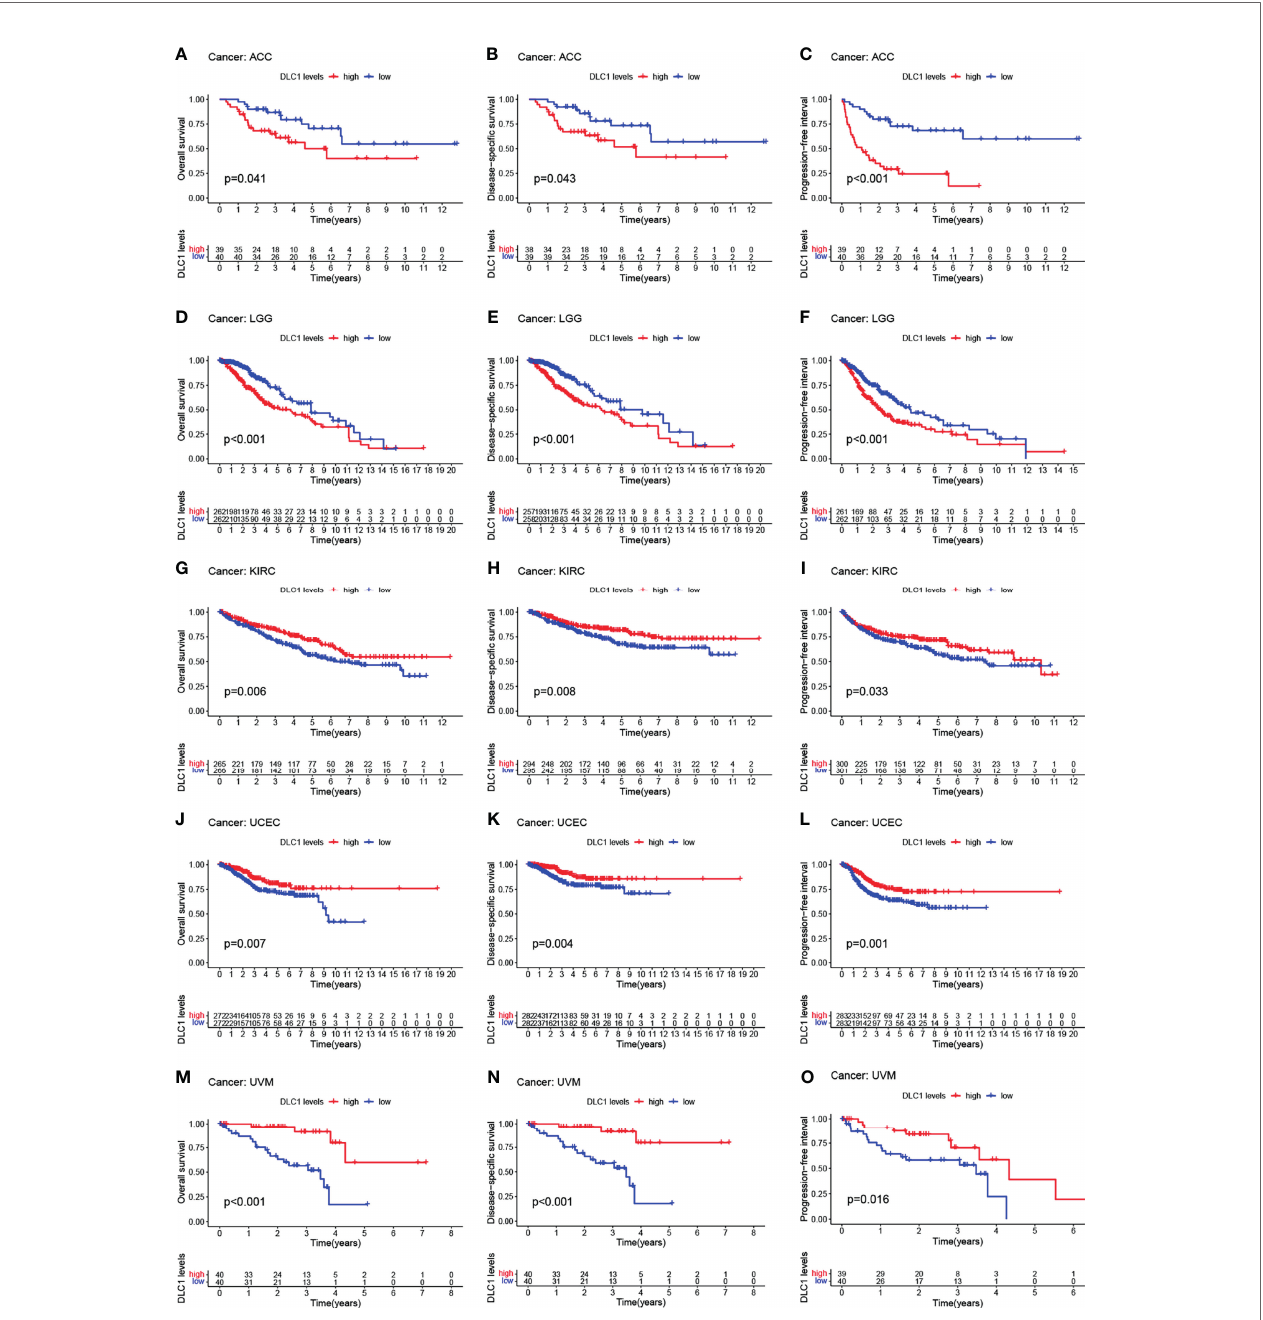
FIGURE 2 | Relationship between DLC1 expression and prognosis of various types of cancer in the TCGA database (A – O) . Patients were divided into high- expression and low-expression groups depending on the comparison with the median expression level using the log-rank test. OS, overall survival; DSS, disease- speci fi c survival; PFI, progression-free